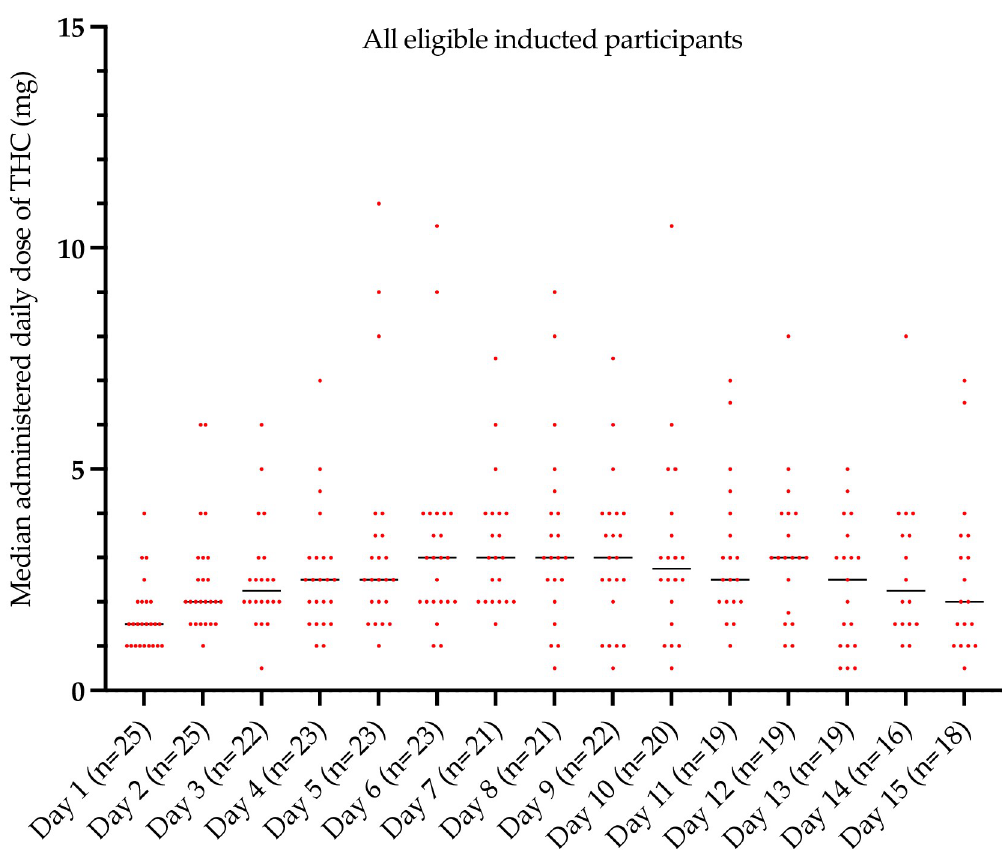
Fig 5. Average daily dose of daily Δ 9-THC doses administered every 4–8 hours unless asleep from day 1 to day 15. [Day 1–3, Day 4–6, Day 7–9 = dose escalation phase; Day 10–15 = treatment phase]. Two and a half times the median amount of Δ 9-THC was co-administered as